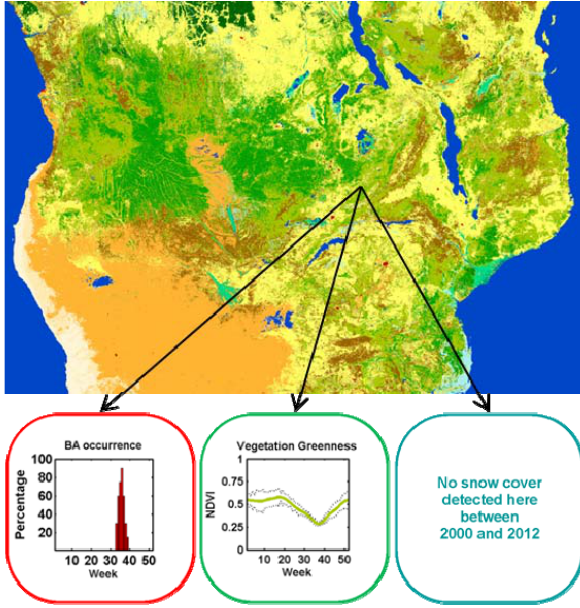
Figure 7. Climatological 7-day time series describing consistently and on a per-pixel basis the natural variability of the vegetation (NDVI), the snow cover and the burned areas Figure 6. The CCI global land cover maps at 300m spatial As an example, Figure 8 shows NDVI profiles extracted from 3 resolution from the 2010, 2005 and 2000 epochs, over part of pixels belonging to 3 LC classes of the 2010 CCI-LC map. The the Amazon basin variety of the dynamic of vegetation is clearly well-captured.